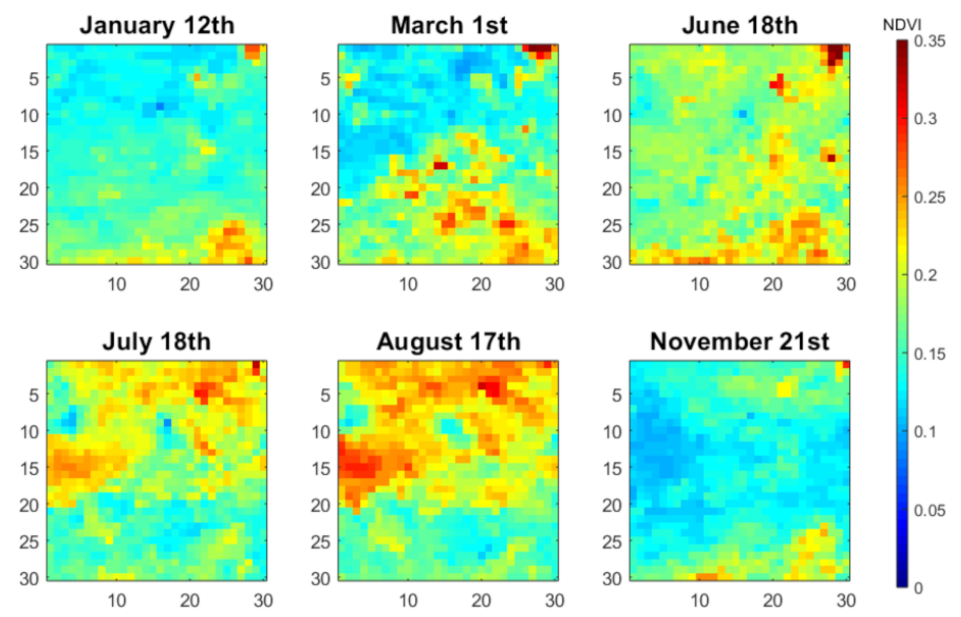
Figure 4. Selected time frames in the SPAIN1 subsection from the Iberian data set (study region 1), which contained no missing data. The important thing to notice here is that the frames change over